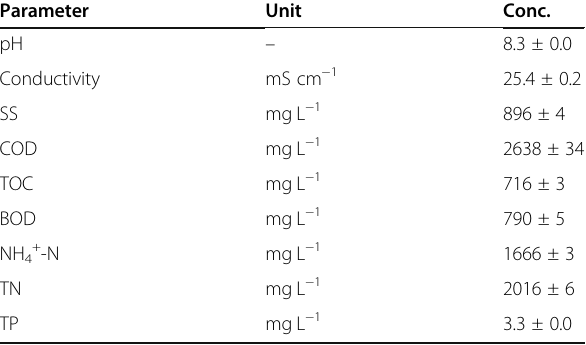
Table 1 Water quality indicators of landfill leachate Parameter Unit